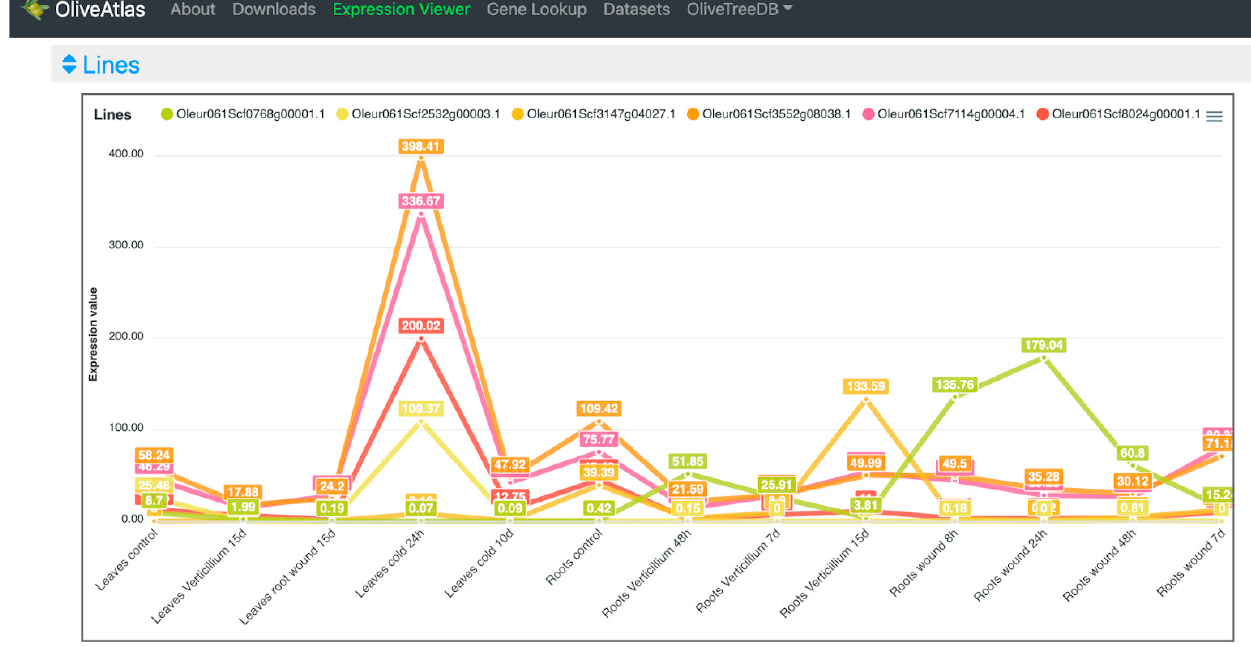
Figure 4. OliveAtlas “Expression viewer” lines plot. Example of six genes described in [18], showing different responses to several stresses.